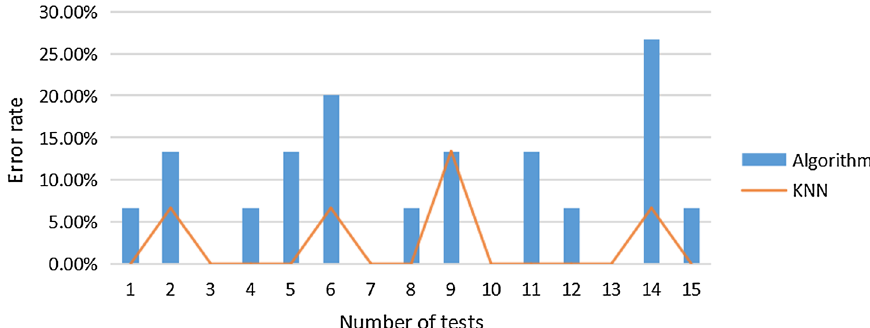
Fig. 5 Errors rate comparison